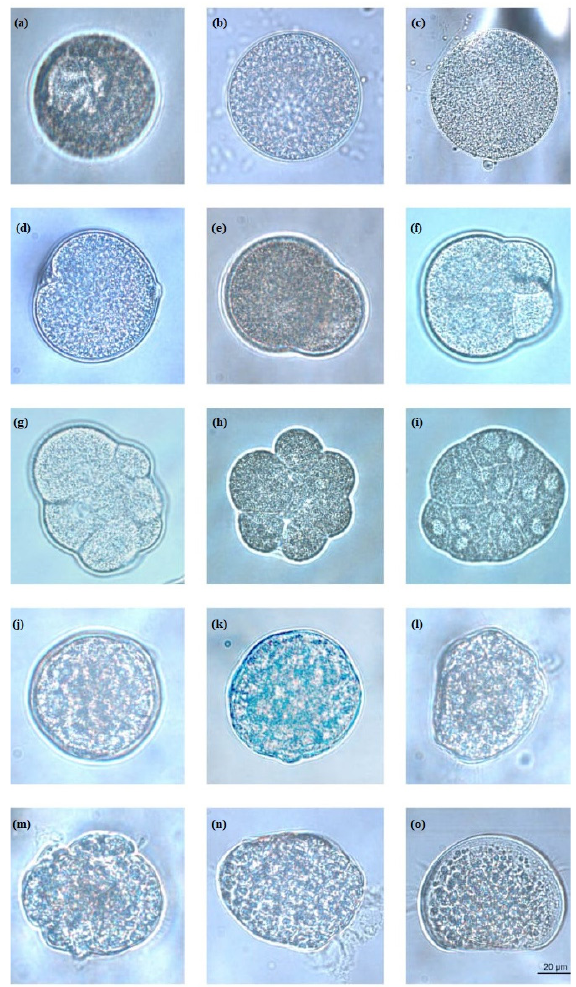
Figure 1. Embryonic developmental stages of Mesodesma mactroides : (a) oocyte; (b) oocyte fertilized with first polar corpuscle; (c) second polar corpuscle; (d) first embryonic division; (e) 2-cell embryo; (f) initial divisions; (g) multiple divisions; (h) multiple divisions; (i) blastula; (j) gastrula; (k) first cilia and swimming movement; (l) trochophore; (m) trochophore; (n) trochophore; (o) D-veliger